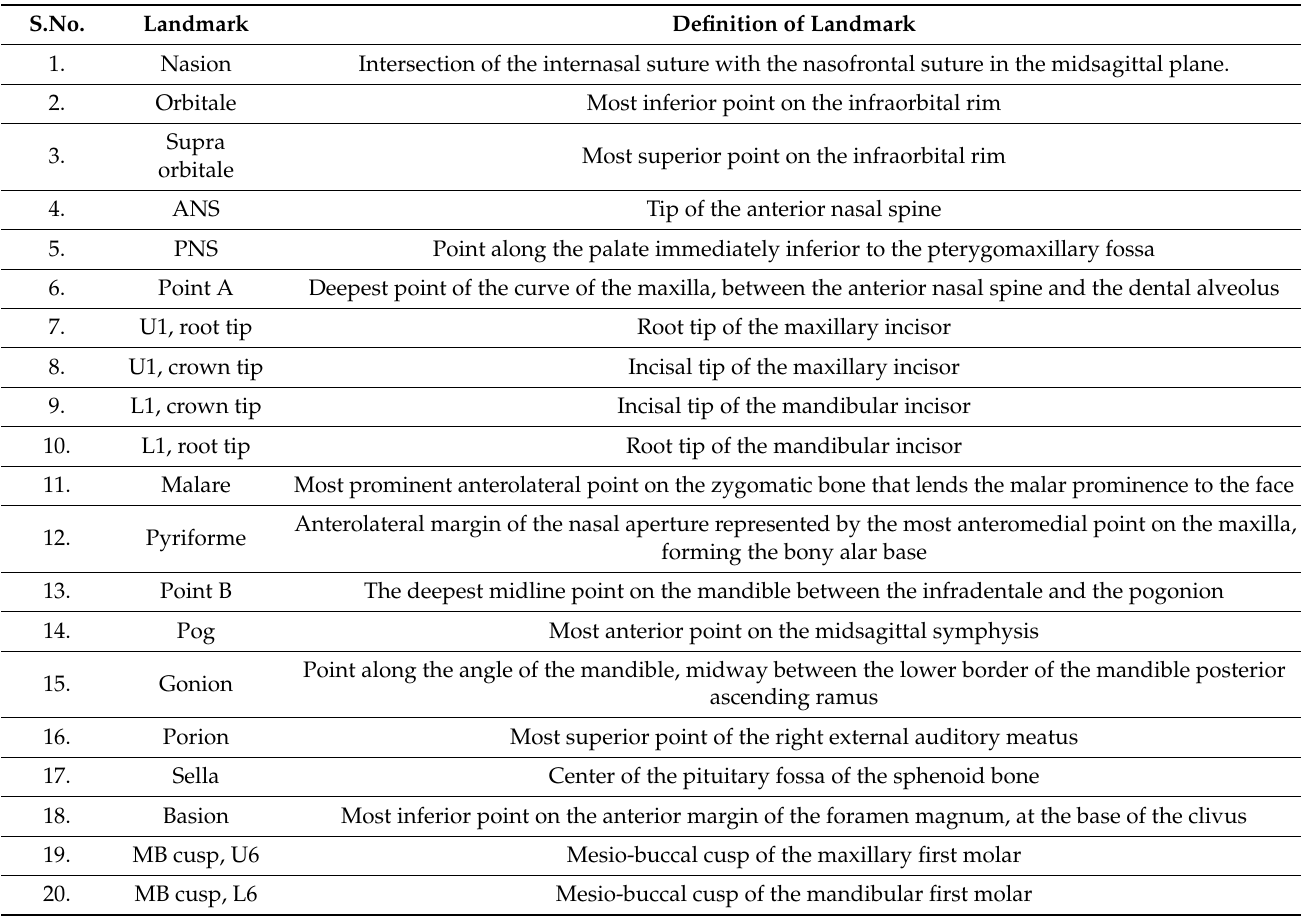
Table 3. Twenty difficult-to-trace